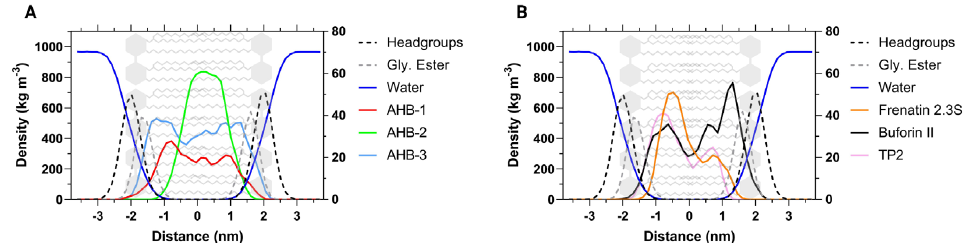
Figure 5. Comparison of average density profiles obtained from a 100 ns simulation. ( A ) novel peptides AHB-1, AHB-2, and AHB-3. ( B ) Reference CPPs Frenatin 2.3s, Buforin II, and TP2. The right y -axis presents the density scale for peptides, while the left y -axis that of the membrane components and bulk water. Headgroups delimit the thickness of the membrane and the interface with water.